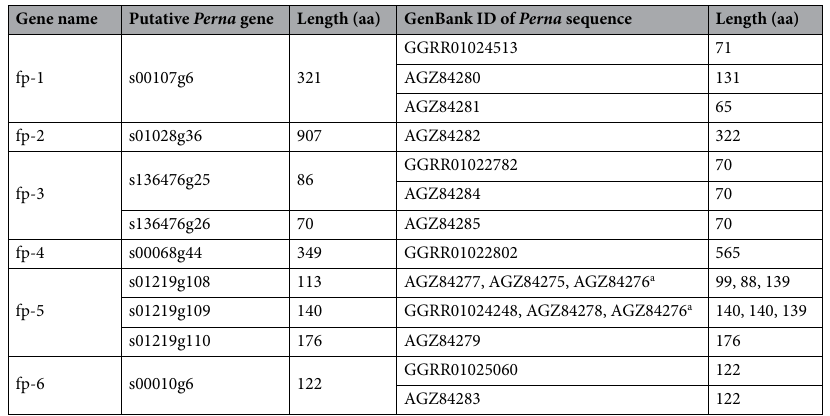
Table 4. Foot protein genes identified in the whole genome sequence of Perna viridis using previously known foot protein sequences as query. Peptide alignments are shown in Supplementary Figs S5 to S11. a Partial matching to the two